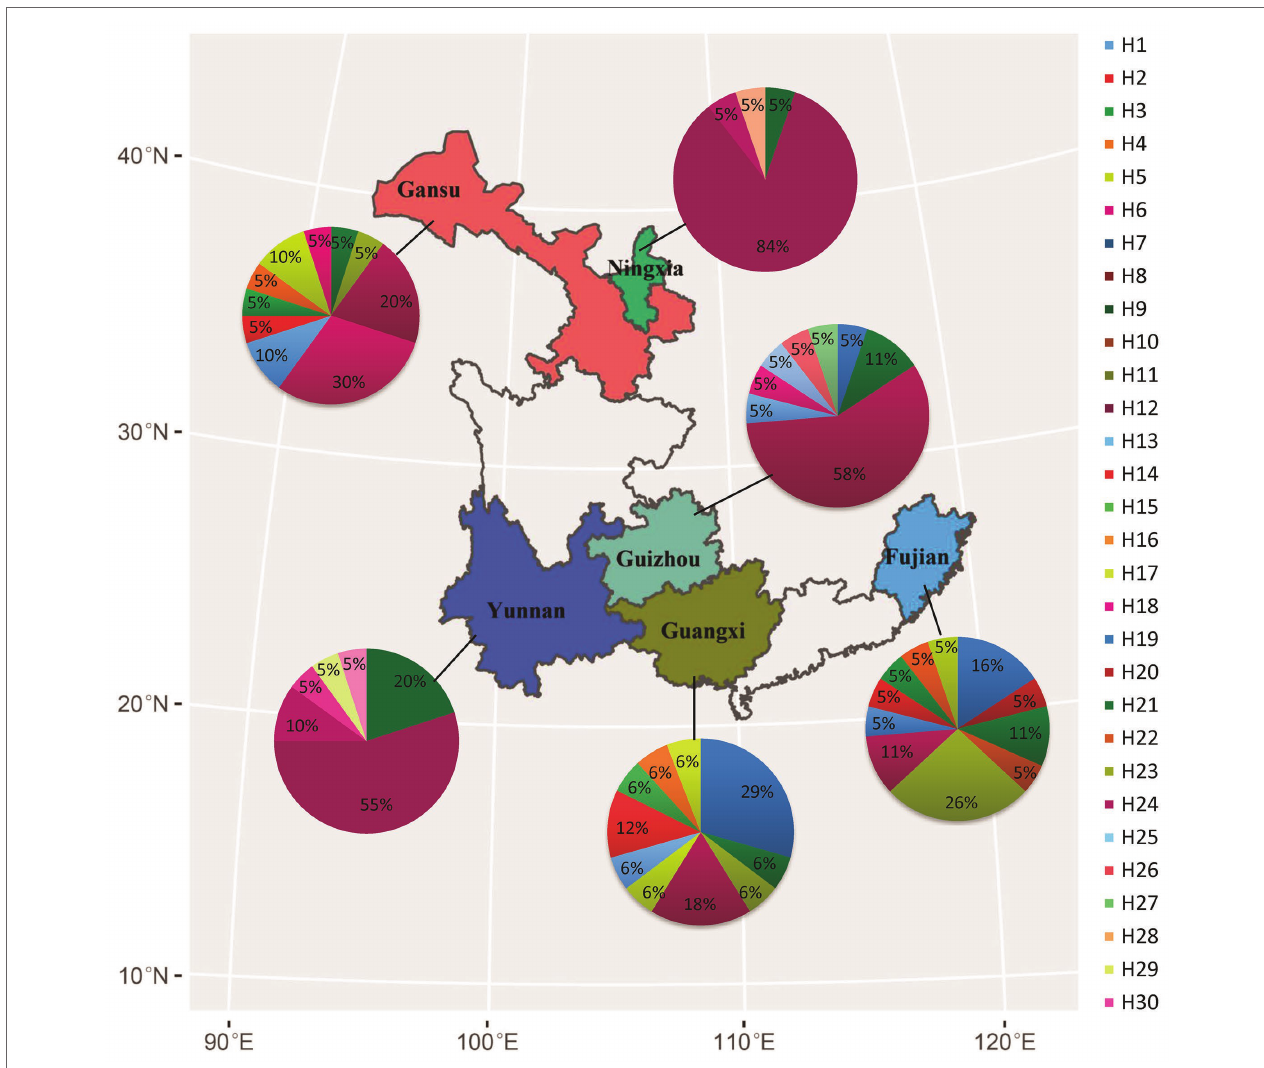
FIGURE 1 | Geographical locations of collection sites, frequency, and spatial distribution of nucleotide haplotypes in the Avr4 gene of P. infestans sampled from six fields in